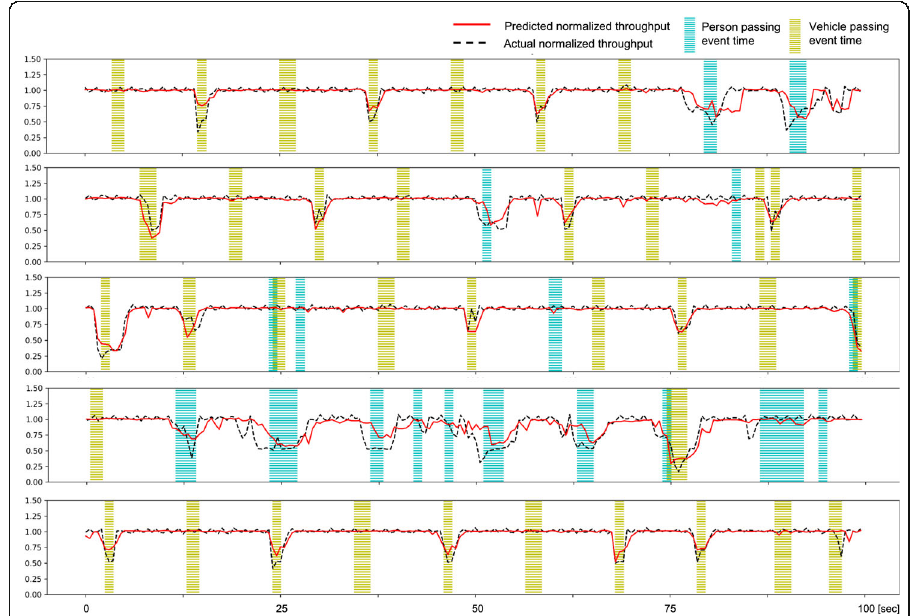
Fig. 10 The predicted throughput using Φ BV [ t 0 ] and the actual normalized throughput, ~ R ½ t 2 (cid:2) for T F = 1.0 [s]. The blue and yellow horizontal strips denote the person passing event timing and vehicle passing event time,